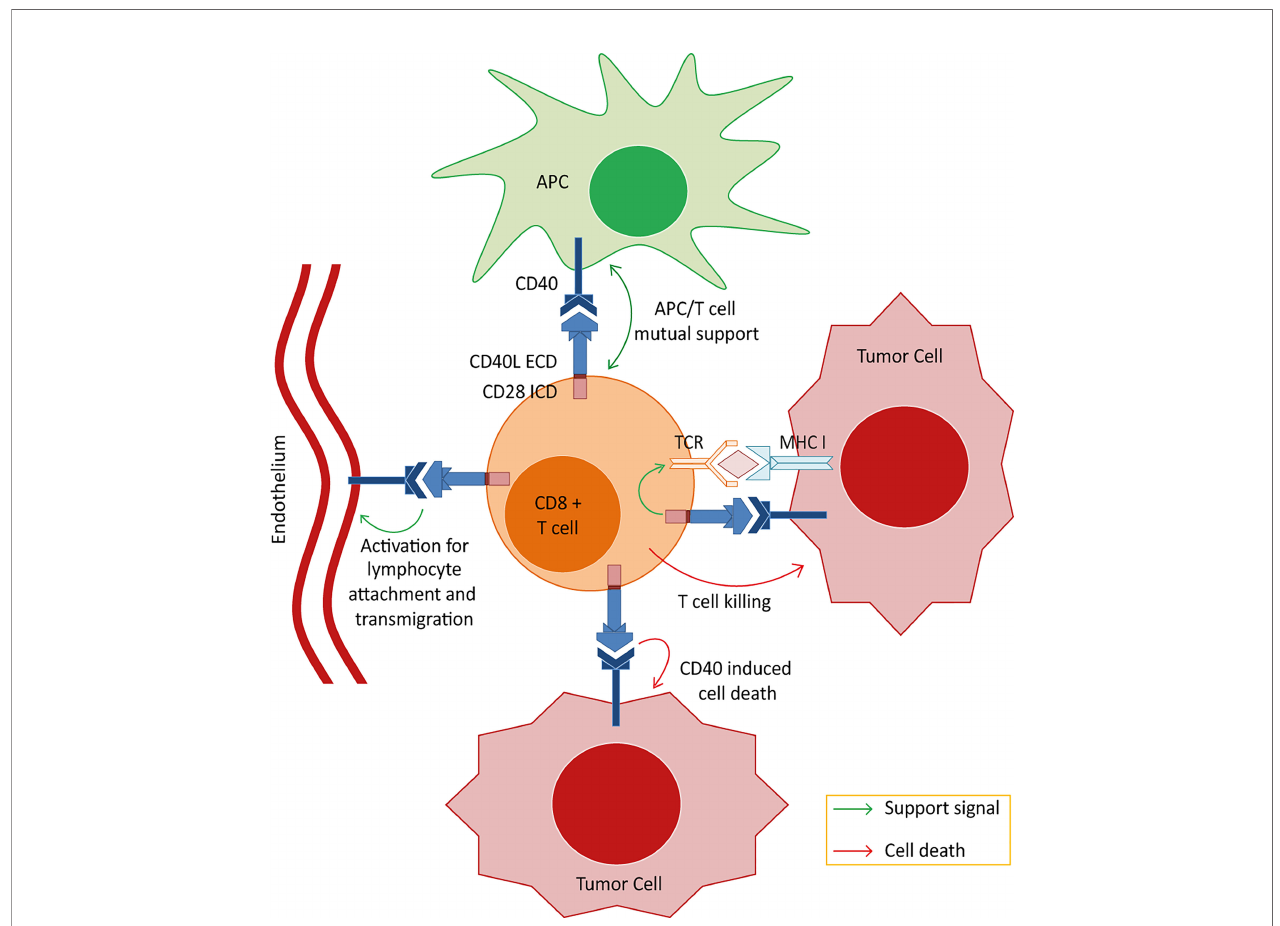
FIGURE 1 | Postulated effector mechanisms for the CD40L:CD28 chimeric co-stimulatory switch proteins (CSPs). Depicted are the 4 potential axes of effector mechanisms of T cells engineered with the CD40L:CD28 CSPs when interacting with different components of the tumor microenvironment. 1) Strengthening the MHC/peptide-triggered TCR signaling through eliciting an intracellular co-stimulatory signaling cascade allowing the T cells to overcome inhibition of effector function in the tumor milieu. 2) Activation of tumor-resident CD40-expressing DCs. Interaction of CD40 on DCs with CD40L expressed on the engineered T cells could induce signals in DCs leading to their maturation with gain in de novo priming capability. 3) Targeting tumor endothelium. CD40 is expressed, amongst others, on neovascular endothelium and CD40 stimulation has been shown to activate human endothelial cells including proliferation and the upregulation of adhesion molecules, enabling T cell attachment and in fi ltration. Targeting this stromal compartment could potentially enhance the immunotherapy effect by depriving the tumor bed of live supporting surroundings and enhancing T cell in fi ltration. 4) Apoptotic effects on tumor cells. It is reported that tumor cells aberrantly express CD40 and that CD40 signals induce apoptotic cell death independent of MHC/peptide-speci fi c targeting. Thus, CD40L:CD28-engineered T cells may kill tumor cells expressing CD40 even if they do not present the cognate TCR-MHC